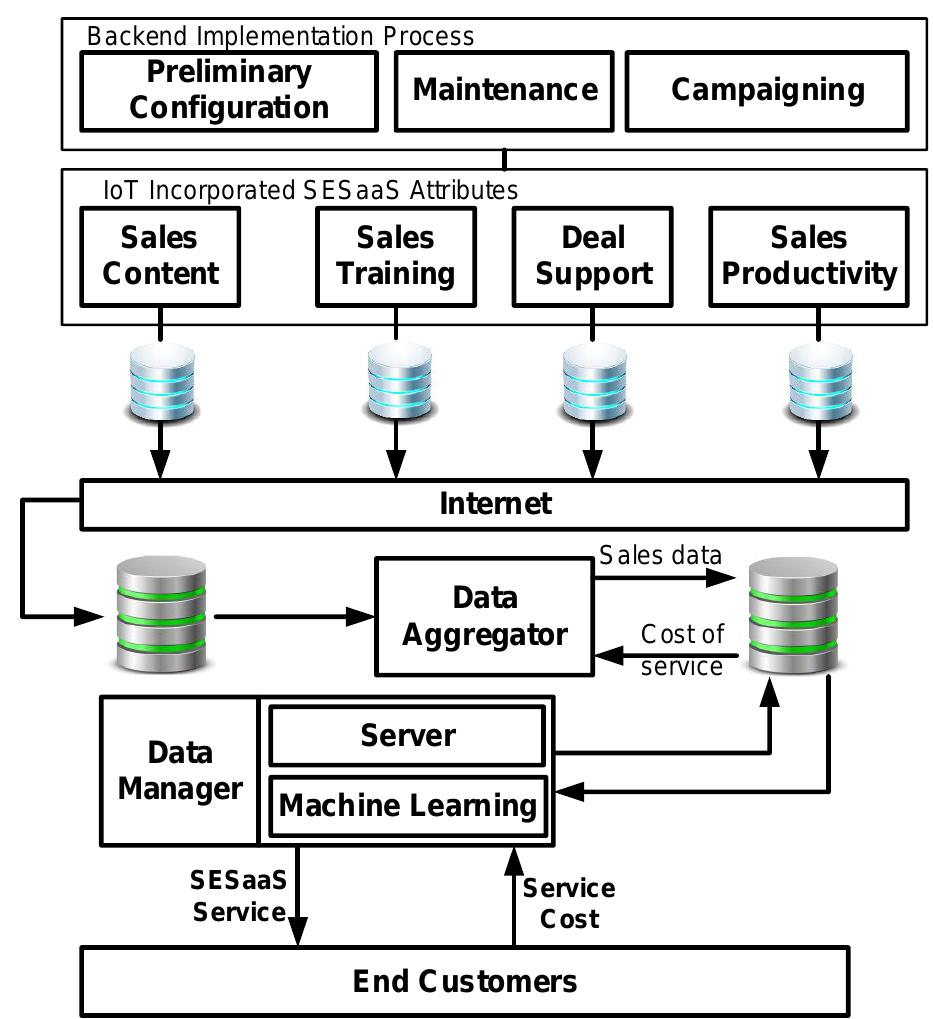
Figure 3. Proposed architecture of IoT-based SESaaS.